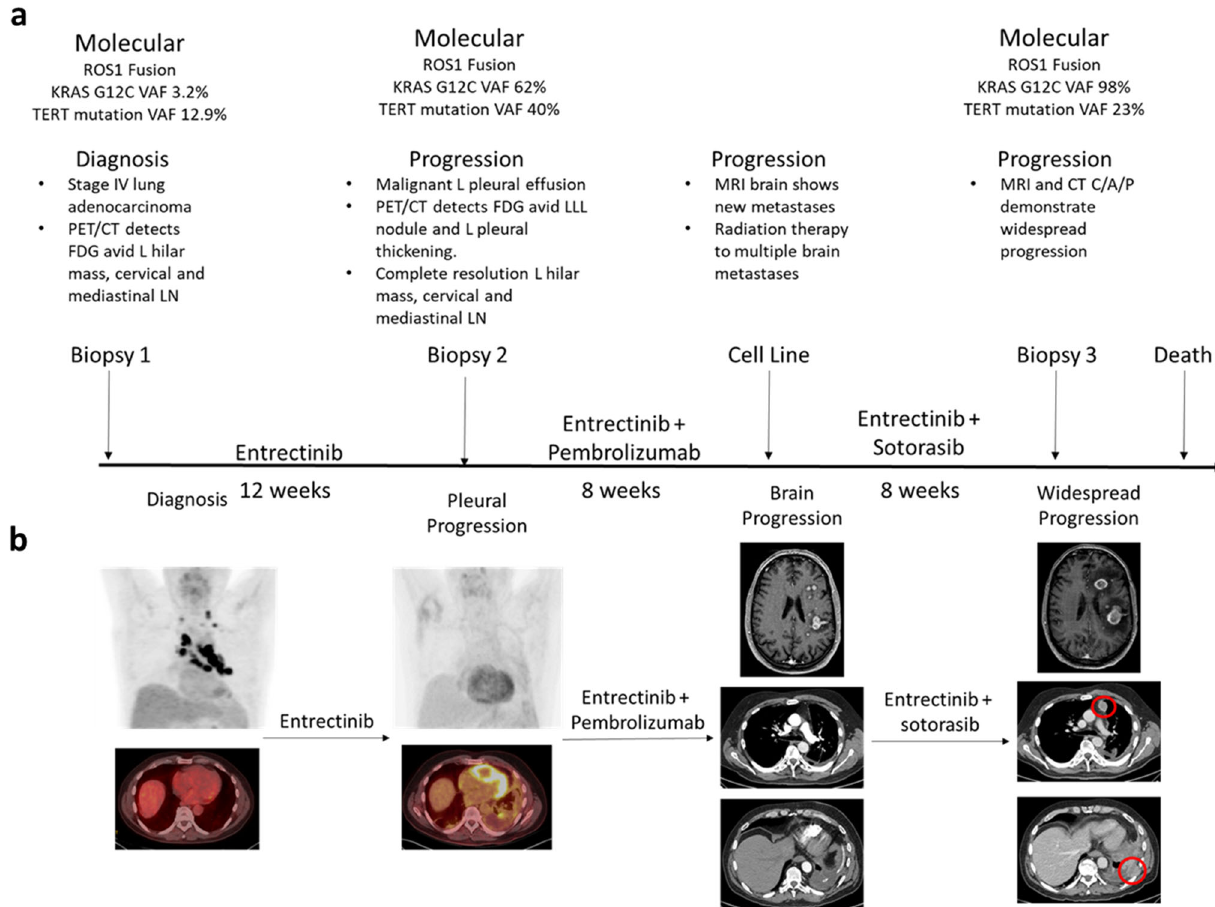
Fig. 1 Patient clinical course. a Timeline of the patient ’ s diagnosis, treatment, and molecular testing results. b Radiographic changes associated with patient ’ s clinical